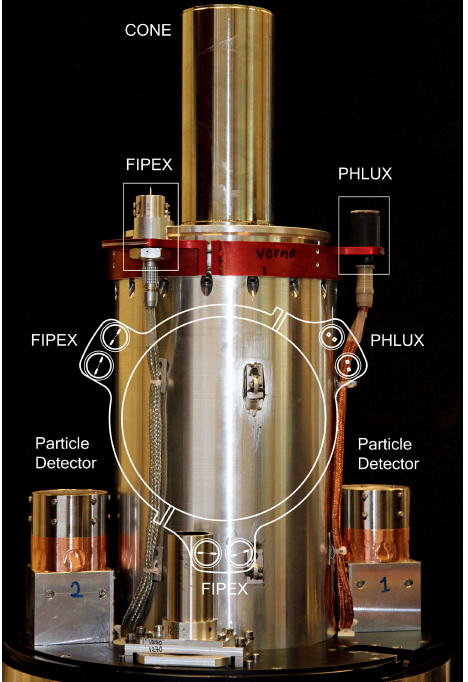
Figure 4. Payload on the fore deck of the rocket with both a FIPEX and PHLUX sensor head visible and a sketch showing their arrange- ment. Other instruments in the photo are the particle detectors and the CONE ionization gauge, all from IAP. CONE is covered by an evacuated